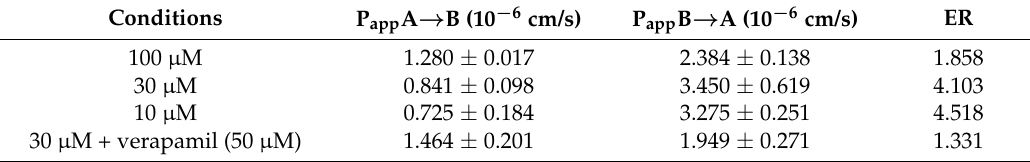
Table 1. The apparent permeability for DL0410 (10–100 µ M) in Caco-2 cell monolayer. (Mean ± SD, n = 3).